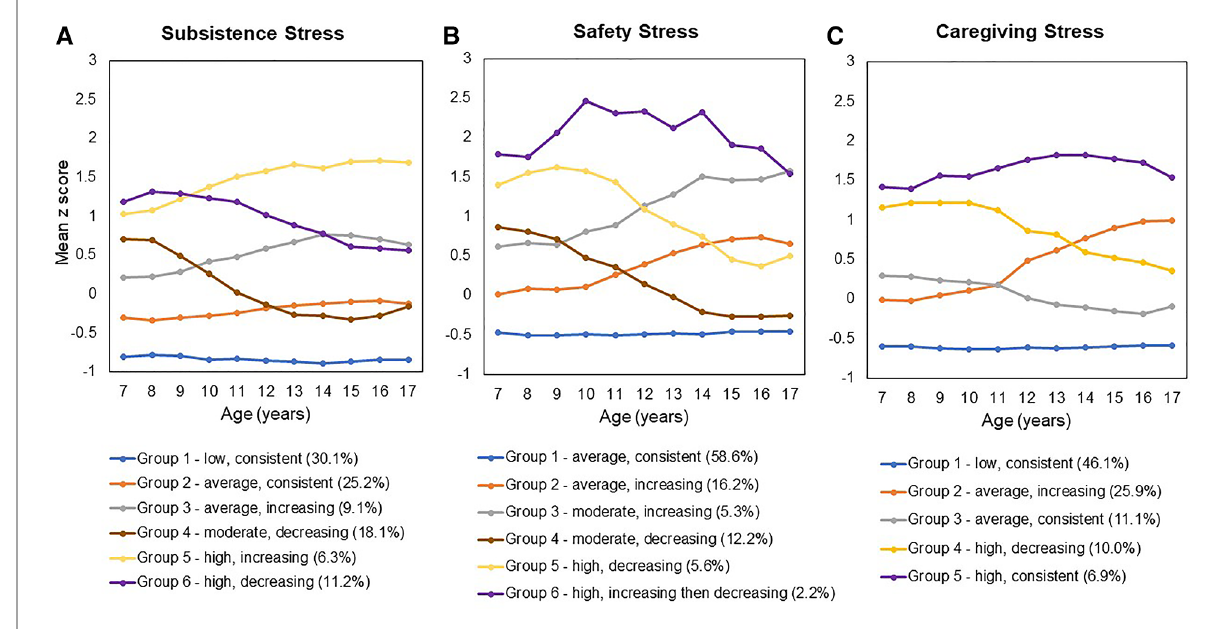
FIGURE 1 (A) Subsistence Stress, (B) Safety Stress, and (C) Caregiving Stress. [Figure reproduced from the authors' previously published work: Keenan et al.